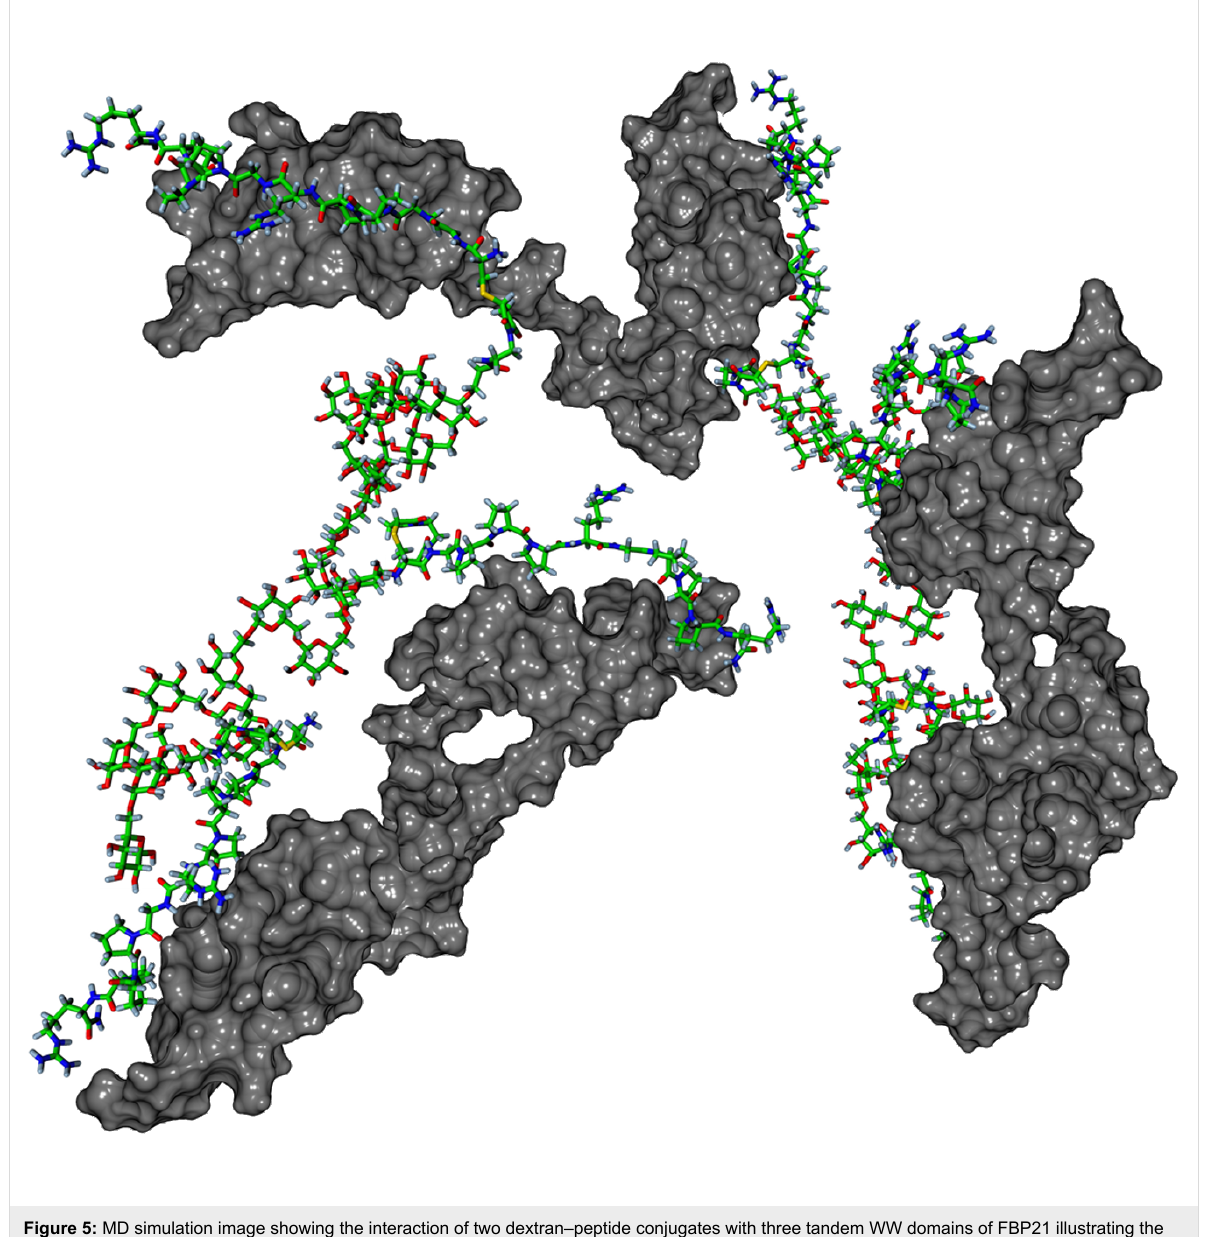
Figure 5: MD simulation image showing the interaction of two dextran–peptide conjugates with three tandem WW domains of FBP21 illustrating the intramolecular mode of binding.